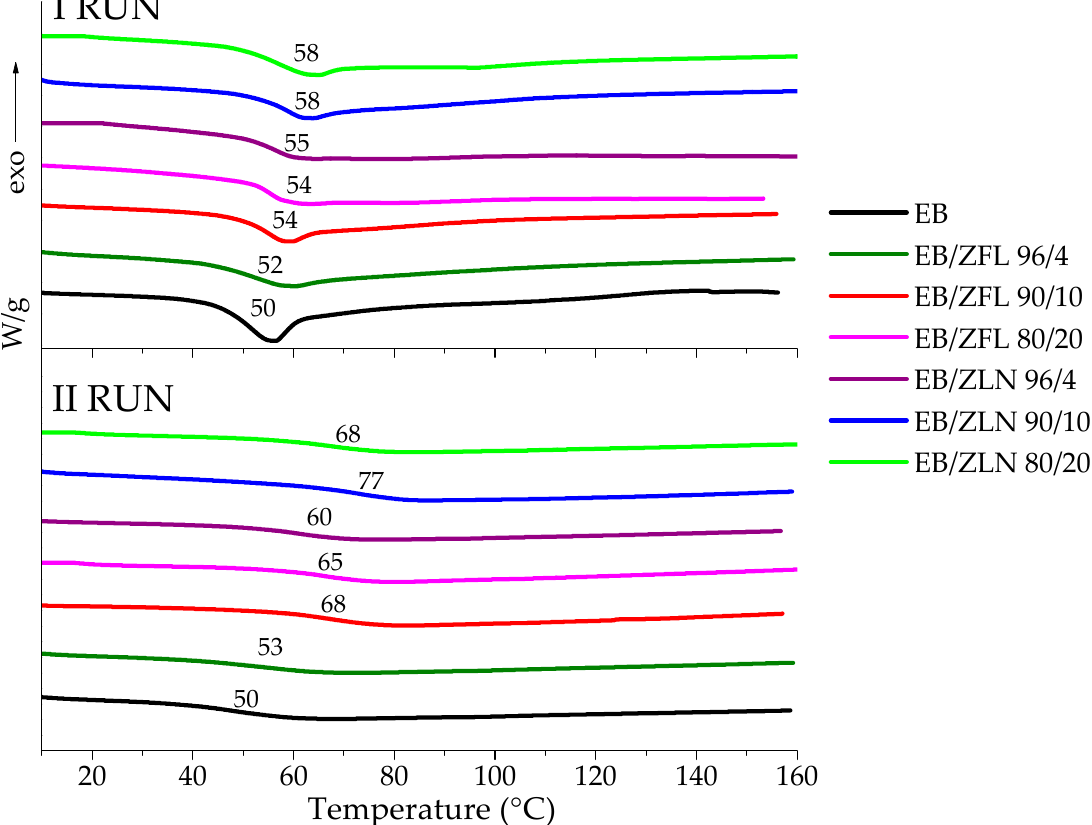
Figure 8. DSC thermograms (1st and 2nd runs) of ZnO composite films (heating rate: 10 °C/min). The arrow indicates the direction of the exothermic flux.